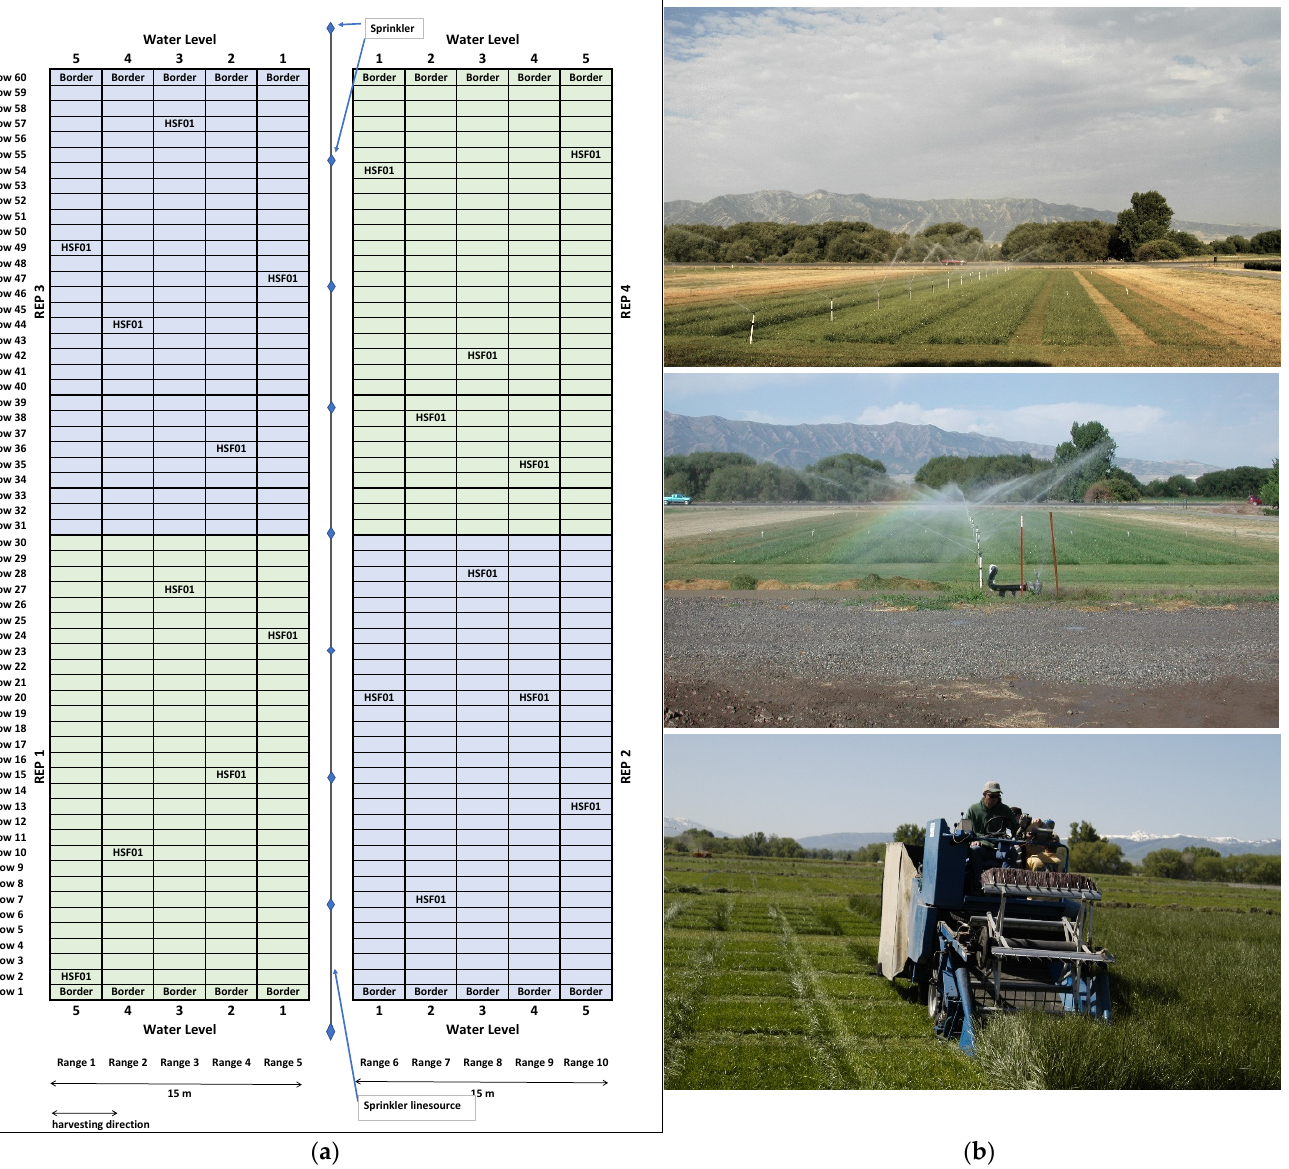
Figure 1. Schematic and pictures of tall fescue line-source experiment from 2001 to 2003 near Logan, UT, USA: ( a ) Diagram of line-source design. Each box represents a 2-m × 1.1-m plot (1-m alleys between plots) and half-sib family (HSF) 01 inserted as an example of layout. ( b ) Pictures of tall fescue line-source in late summer showing irrigation gradient (top, August 2003), being irrigated (middle, August 2002), and harvested (bottom, April 2003).